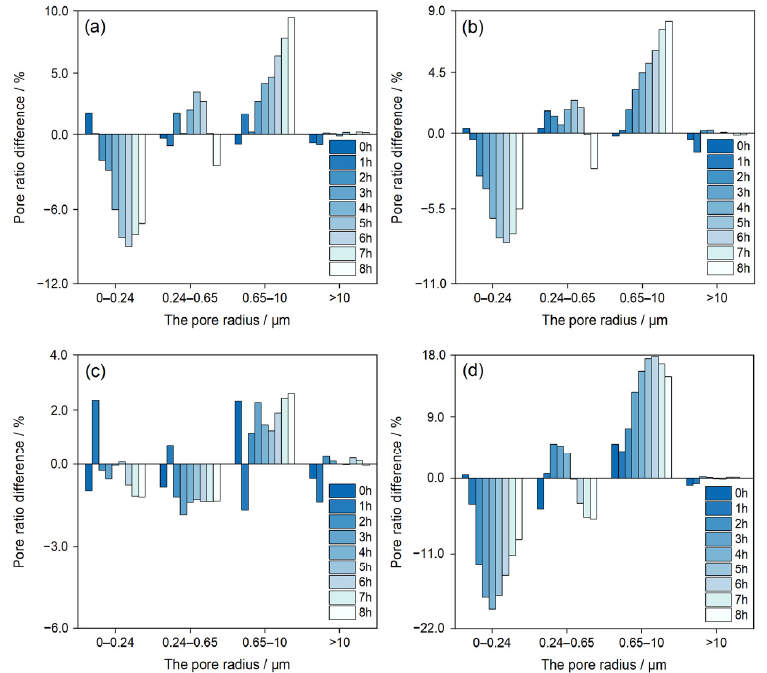
Figure 12. Comparative distribution of differences of different Pore structure of samples during the leaching process of magnesium sulfate solutions with different pH: ( a ) difference of pore propor- tion between solutions with pH = 2 and pH = 3; ( b ) difference of pore proportion between solutions with pH = 4 and pH = 3; ( c ) difference of pore proportion between solutions with pH = 5 and pH = 3; ( d ) difference of pore proportion between solutions with pH = 6 and pH = 3.